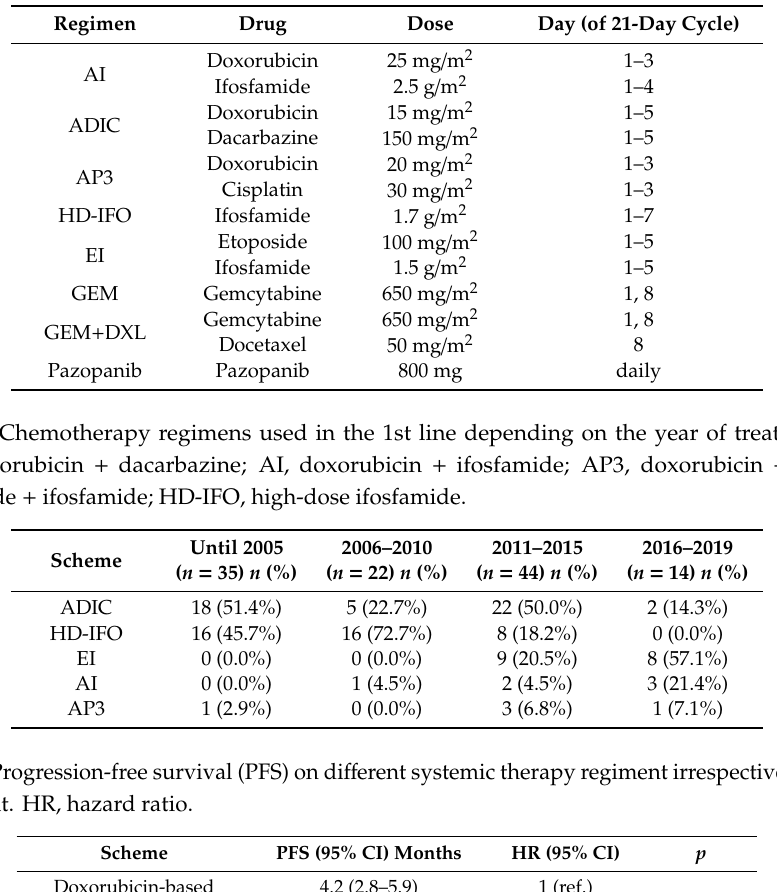
Table A1. Details of main chemotherapy regimens used in the treatment of patients with MPNST. ADIC, doxorubicin + dacarbazine; AI, doxorubicin + ifosfamide; AP3, doxorubicin + cisplatin; EI, etoposide +